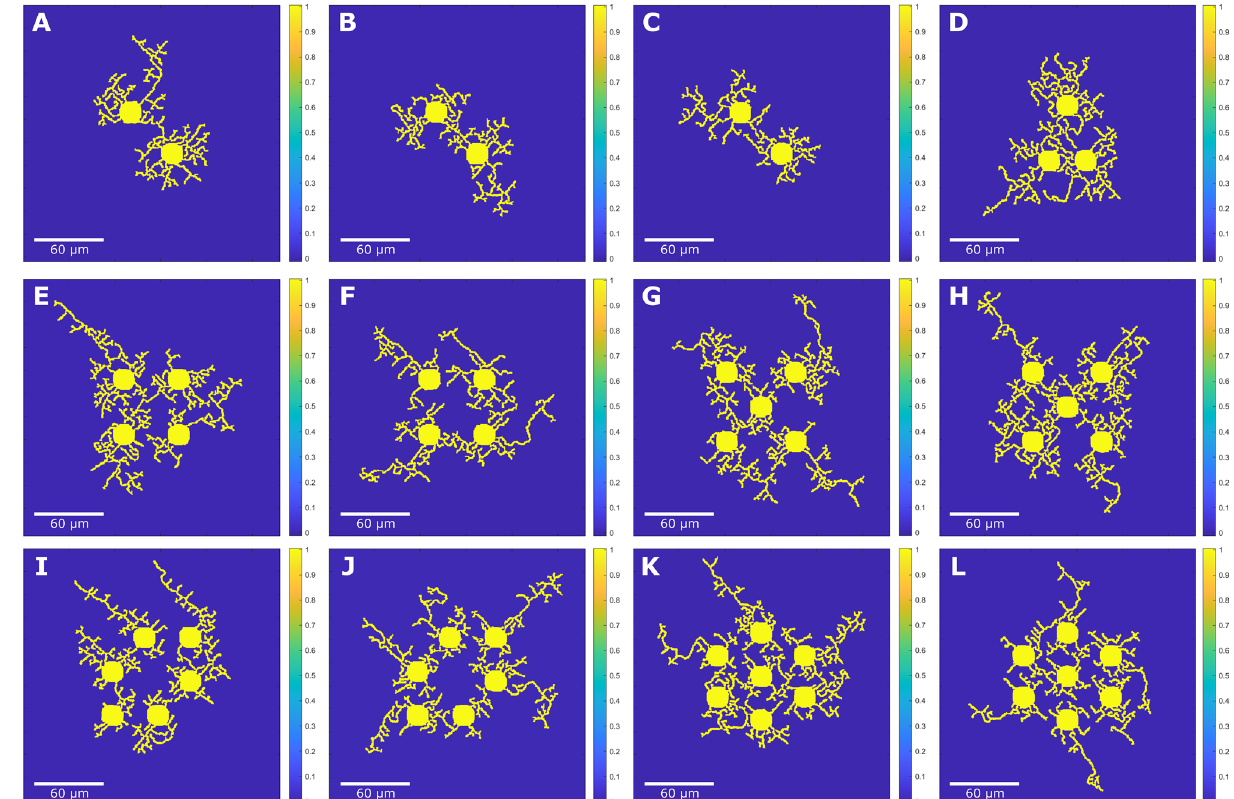
Figure 3. Phase field model results of multiple neurons with all 4 growth stages using different random θ initializations with the grid size of 560 × 560 . Neuron growth simulation with neurite interaction is shown for ( A – C ) 2 neurons ( 453 × 453 , 393 × 393 , 383 × 383 ), ( D ) 3 neurons ( 353 × 353 ), ( E , F ) 4 neurons ( 493 × 493 , 463 × 463 ), ( G , H ) 5 neurons ( 523 × 523 , 533 × 533 ), ( I , J ) 6 neurons ( 533 × 533 , 493 × 493 ), and ( K , L ) 7 neurons ( 553 × 553 , 543 × 543 ). Using self-intersection check, multiple neurons exhibit neurite interactions with each other while preventing interactions between neurites belonging to the same neuron, demonstrating that the model can handle multi-neuron interactions during simulation. Simulations are plotted using the same domain size and scale bars are calculated based on cell body diameter observed in experimental images shown in Fig.